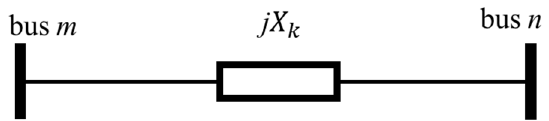
Figure 2. Inserted X variable for bus splitting and current limiting reactor installations.